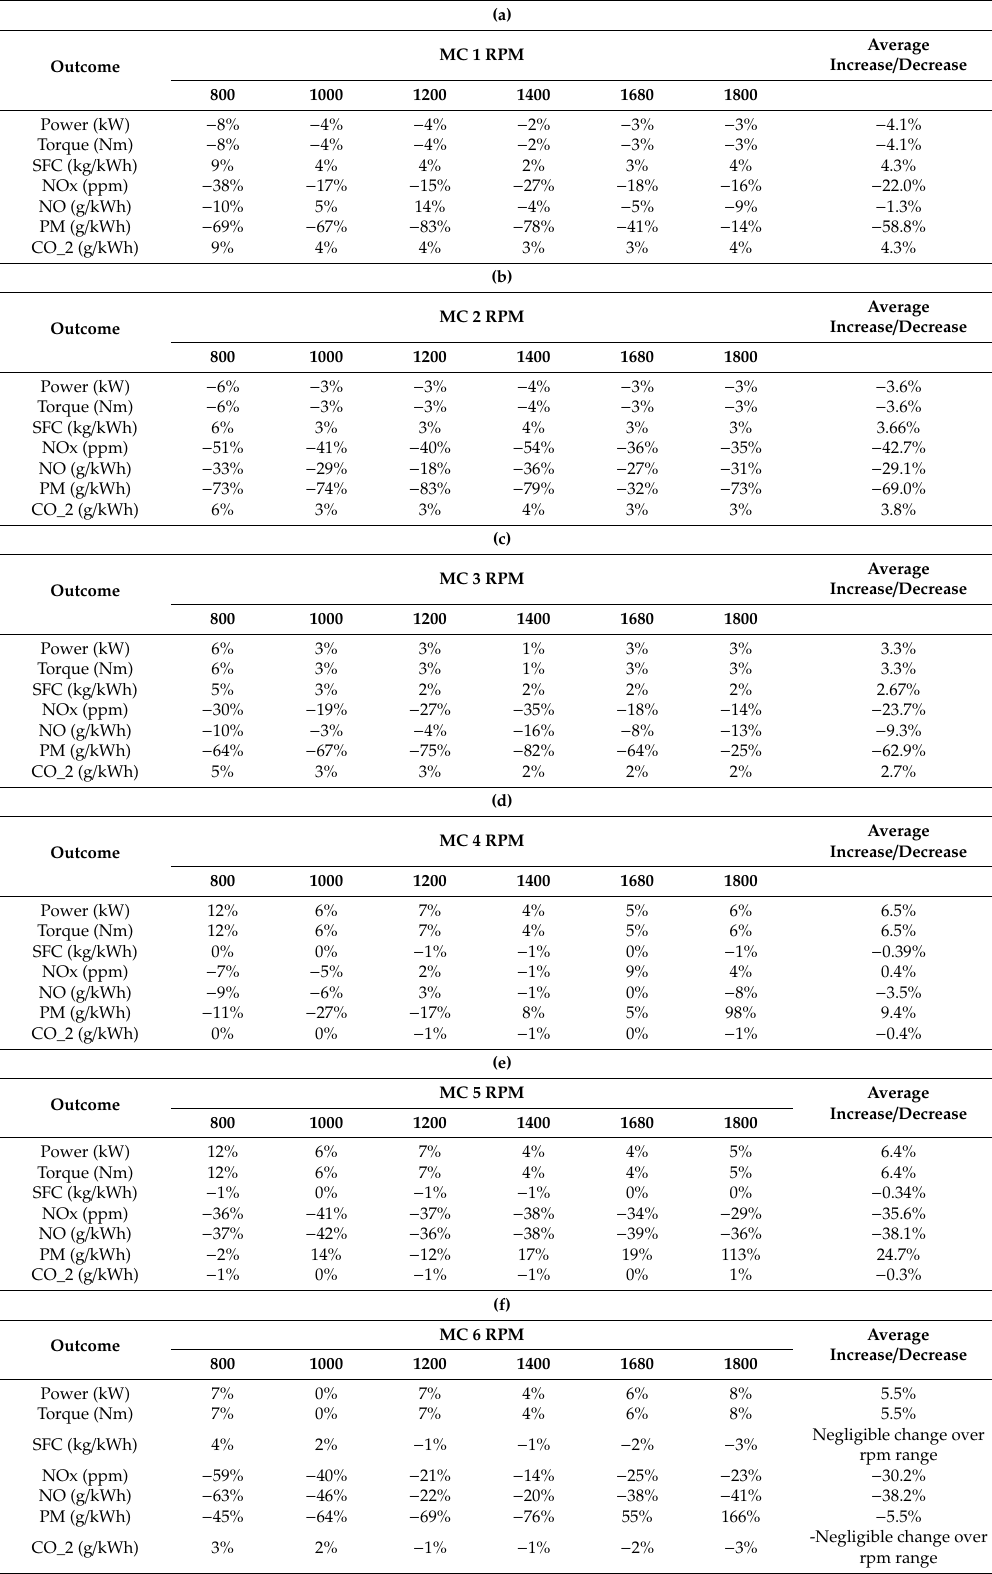
Table 6. Engine performance operating on Miller Cycle in comparison to